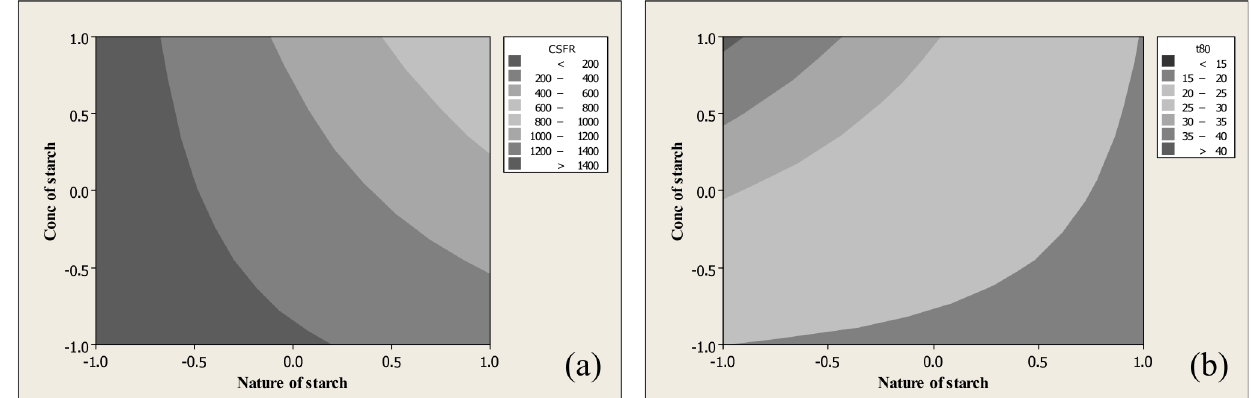
) of chloroquine phosphate 80